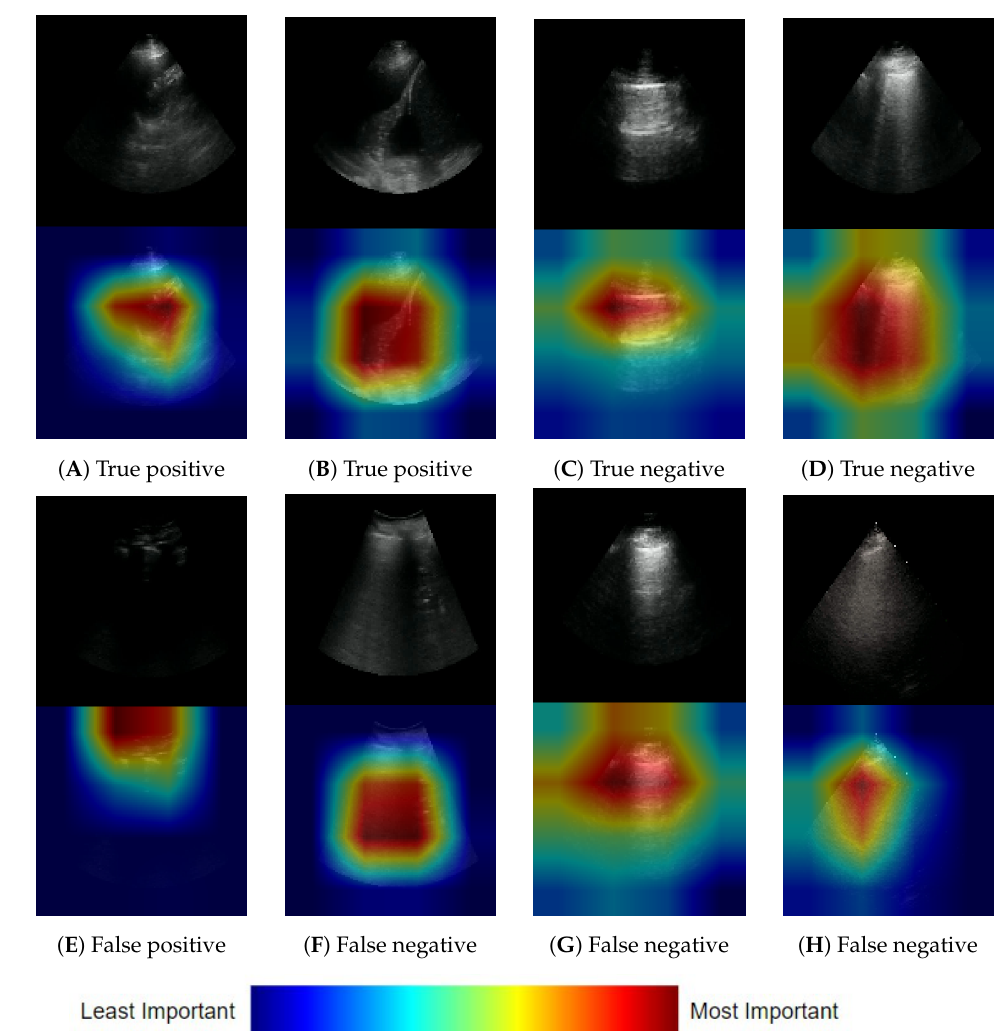
Figure A1. Additional Grad-CAM++ heatmaps from true positive ( A , B ), true negative ( C , D ), false positive ( E ), and false negative ( F – H ) example frames. Red regions were the most important to the prediction. True positive frames demonstrate activation on abdominal organs ( A ) and areas featuring pleural effusion, consolidation, and diaphragm ( B ). True negative frames demonstrate activation on the bat wing sign (pleural line bordered by rib shadows), A line artefacts ( C ) and B line artefacts ( D ). The false positive frame ( E ) shows activation proximal to the pleural line, likely because the clip was under-gained and lacked appreciable features of typical parenchymal clips. False negative frames showed activation in areas of aerated lung despite the presence of abdominal organs ( F , H ) and features found in parenchymal clips (pleural line and A lines) due to the probe being positioned superiorly during the first part of the acquisition ( G